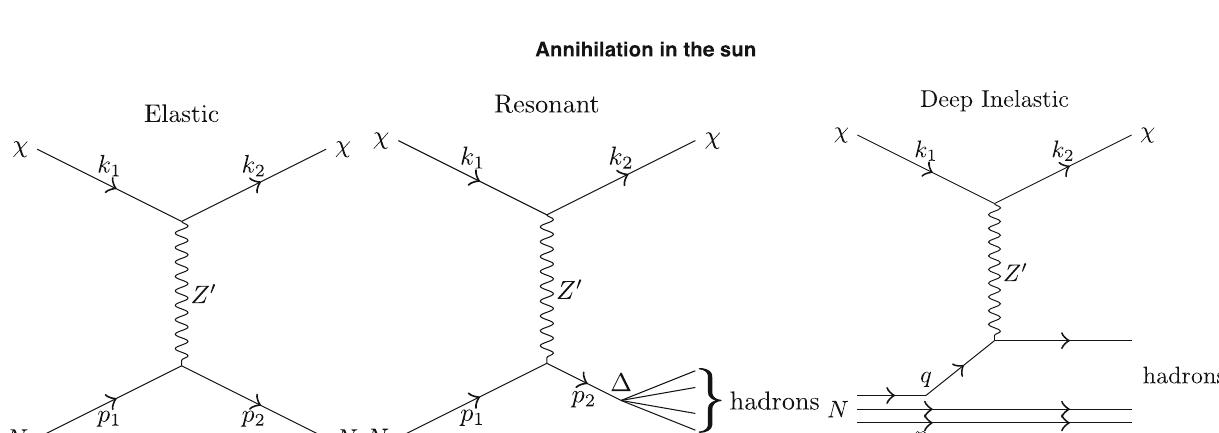
Fig. 23 The chain of processes leading to boosted DM signal from the sun. The semi-annihilation and two-component DM models refer to the two examples of the non-minimal dark-sector scenarios introduced in the beginning of Sect. 8. DM (cid:5) denotes the lighter DM in the two-component DM model. X is